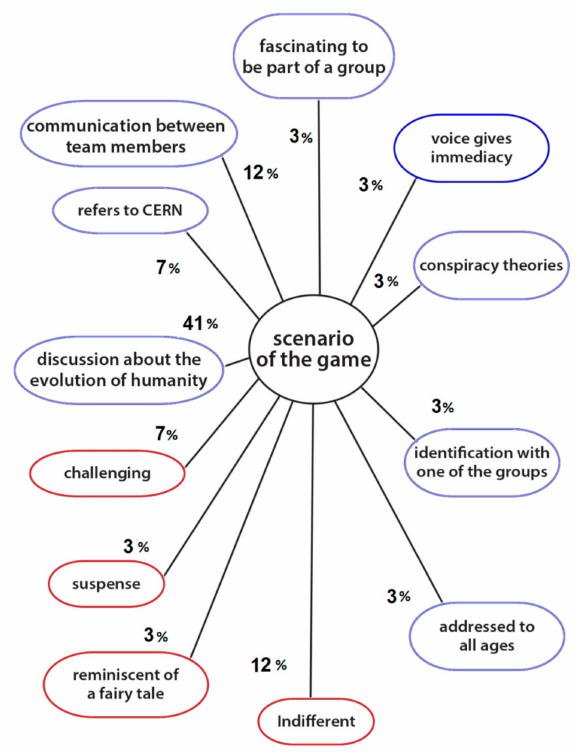
Figure 2. Subthemes with percentages of mentions related to the main thematic “scenario of the game” (question 2). Subthemes in red relate to the user, those in blue relate to society, and those in dark blue relate to the